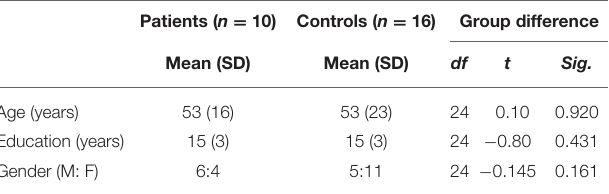
TABLE 1 | Demographic variables for patients with amyotrophic lateral sclerosis (ALS) and healthy